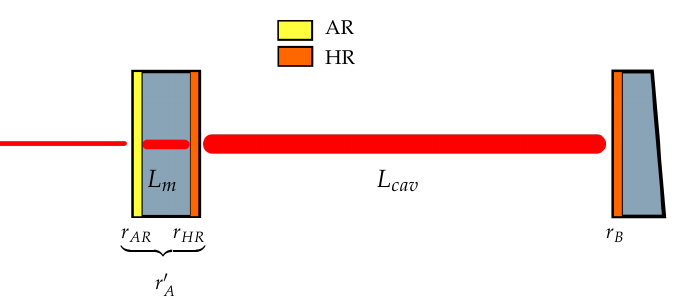
Figure 1. Schematic of a Fabry–Perot arm cavity with the etalon effect shown in the input test mass substrate and relevant parameters.